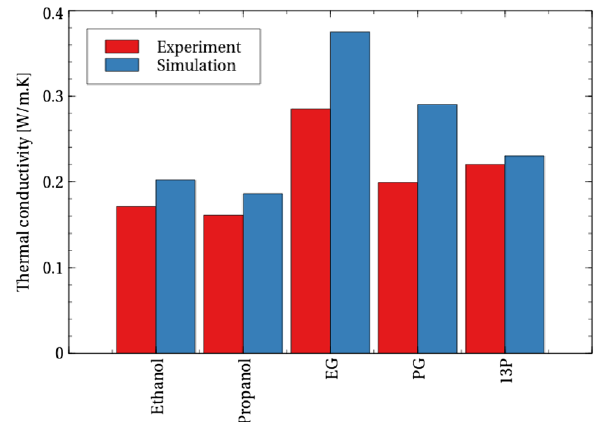
Figure 2. A comparison of the overall thermal conductivity at 300 K between the simulation models used in this work and experiment 21–23 . As is typical in molecular simulation, thermal conductivity is generally over- estimated, and with the exception of PG-13P, relative values are